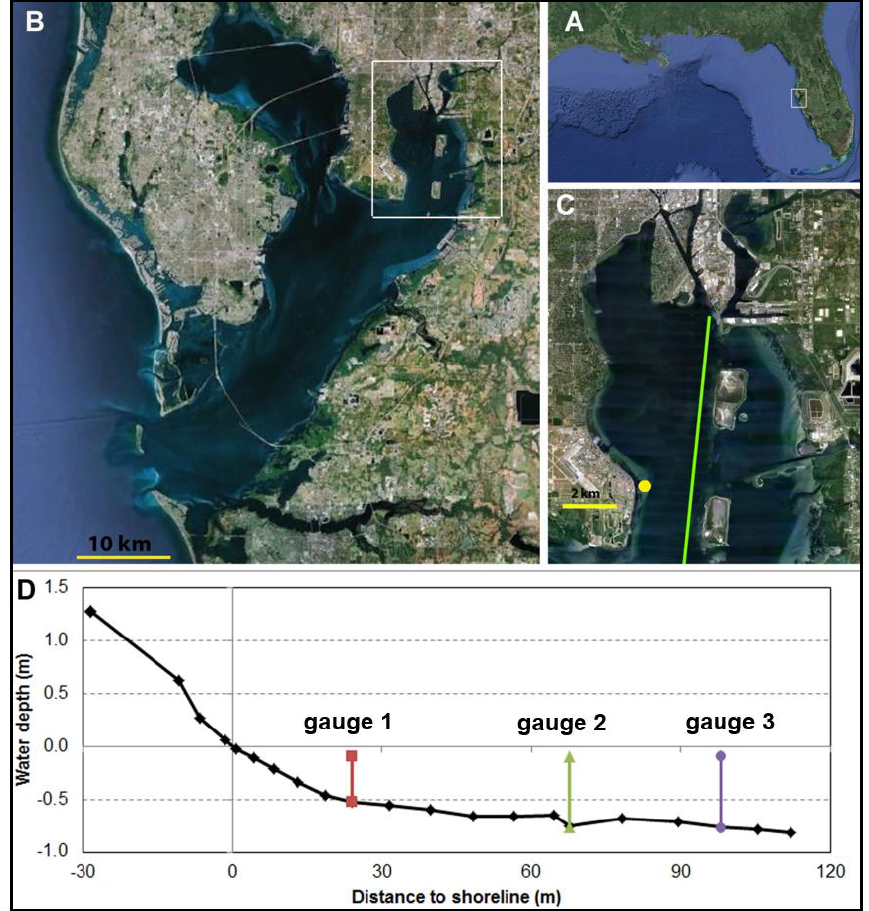
Figure 1. The field study site at Upper Tampa Bay. ( A ) The Southeast US and the Gulf of Mexico coasts. ( B ) Tampa Bay. ( C ) Upper Tampa Bay, illustrating the main shipping channel (green line) and the study site (yellow circle). ( D ) The gentle nearshore profile and locations of the three measurement stations.